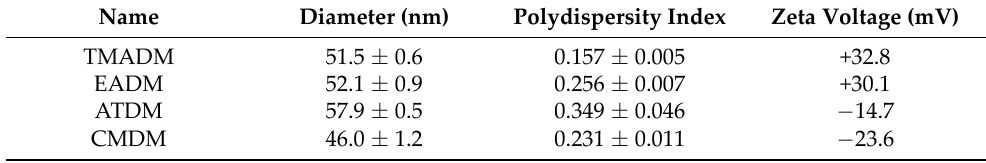
Figure 1. ( A ) SEM micrograph of polysaccharide magnetic iron oxide nanoparticles (( a ). TMADM, ( b ). EADM, ( c ). ATDM, ( d ). CMDM). Scale bar: 50 nm; ( B ) TEM micrograph of polysaccharide magnetic iron oxide nanoparticles (( a ). TMADM, ( b ). EADM, ( c ). ATDM, ( d ). CMDM). Scale bar: 50 nm. Table 1. Characteristic features of synthesized polysaccharide magnetic iron oxide nanoparticles.